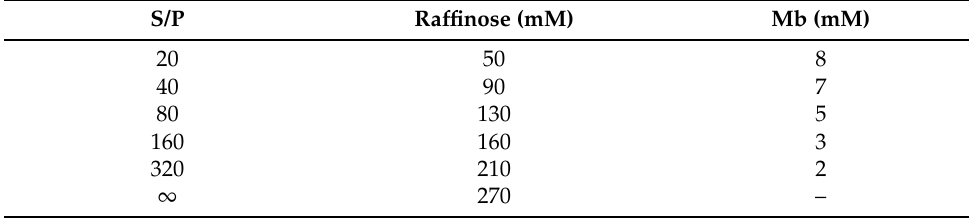
Table 3. Molar concentration of protein and raffinose used to prepare the